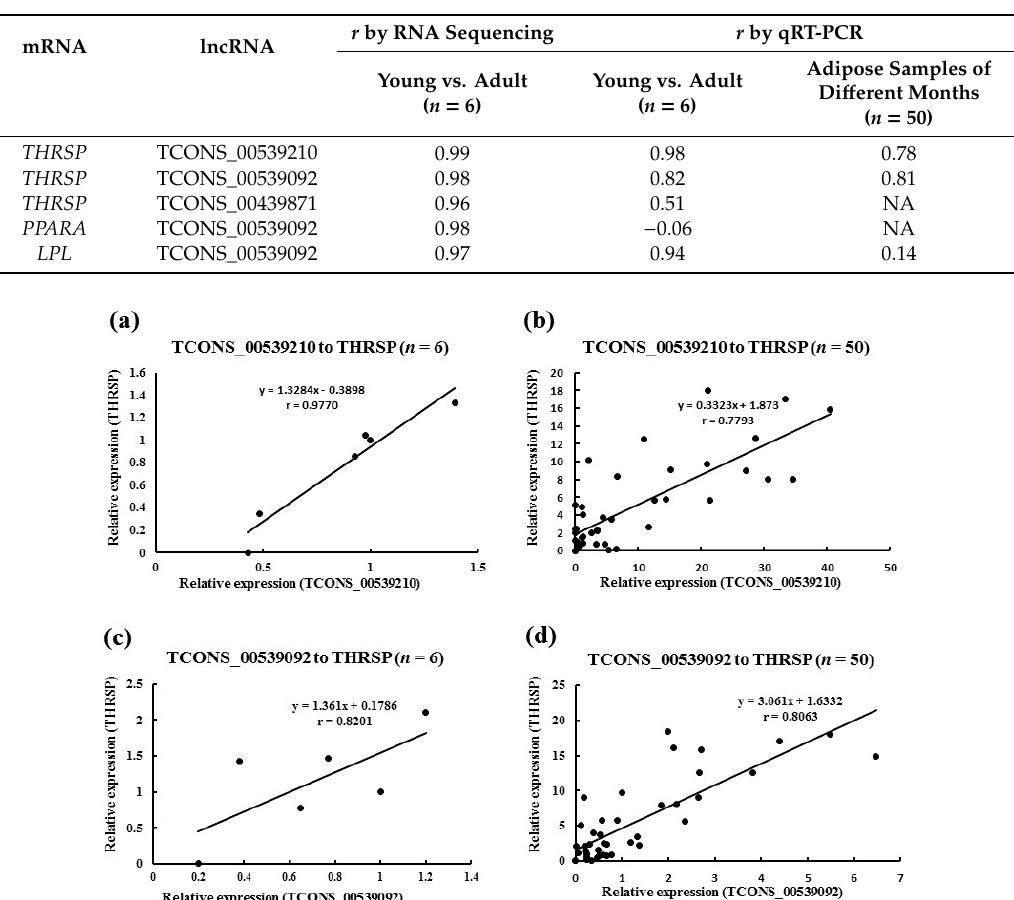
Table 1. mRNA–lncRNA pairs validation using qRT-PCR.